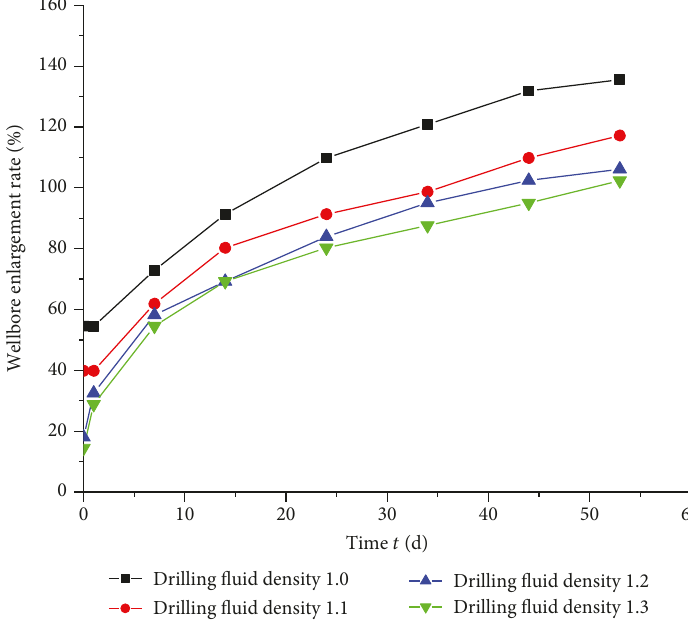
Figure 17: Curves of the wellbore enlargement rate with time under di ff erent drilling fl uid